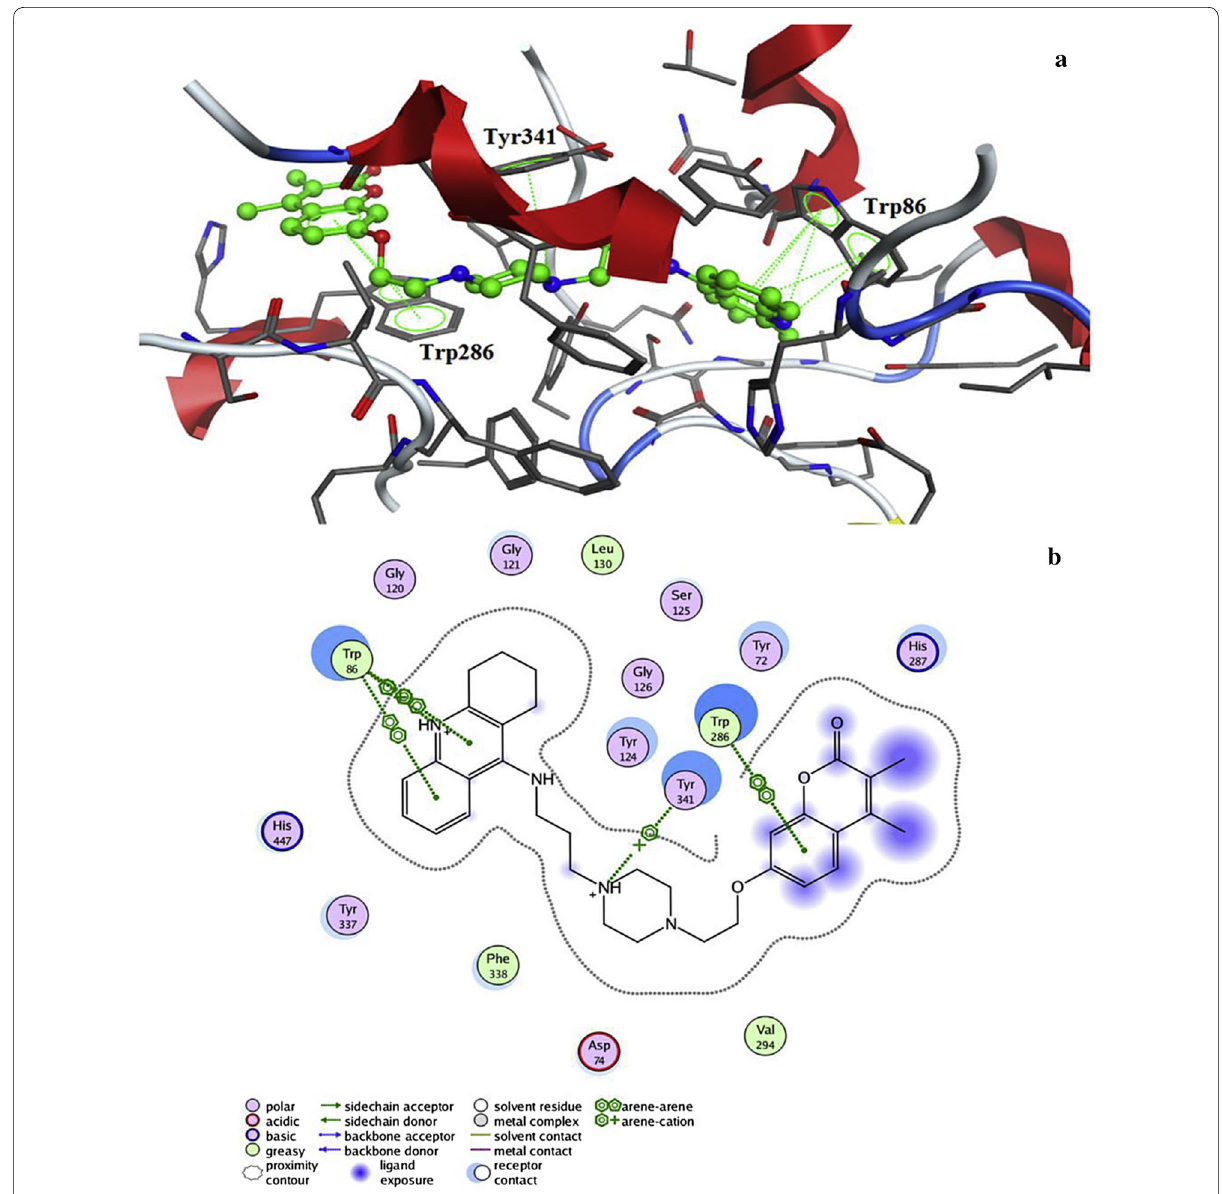
Fig. 85 a 3D docking model of compound C95 with AChE. b 2D schematic diagram of docking model of compound C95 with AChE